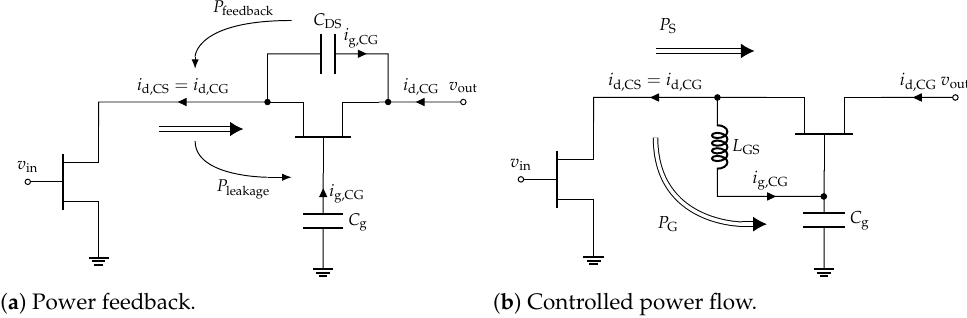
Figure 10. Gate power leakage compensation.